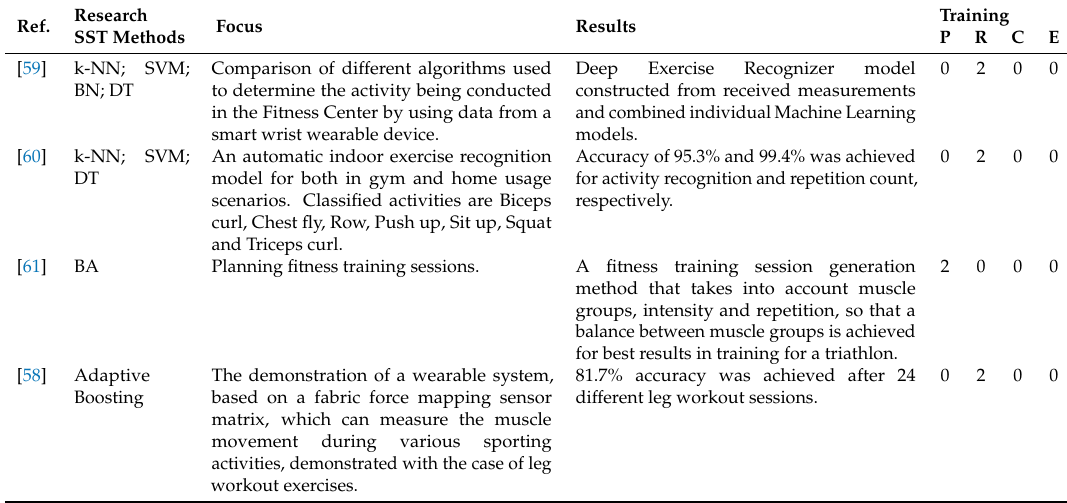
Table 7. Identified studies in the domain of fitness.